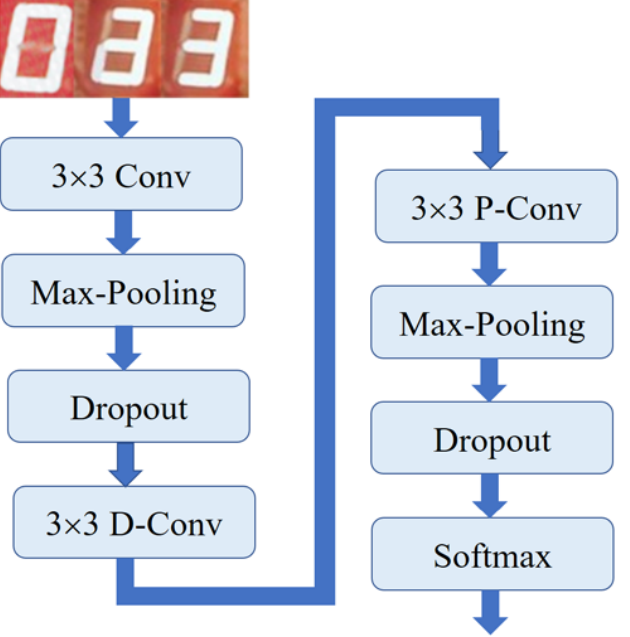
Figure 11. The architecture of the proposed deep learning